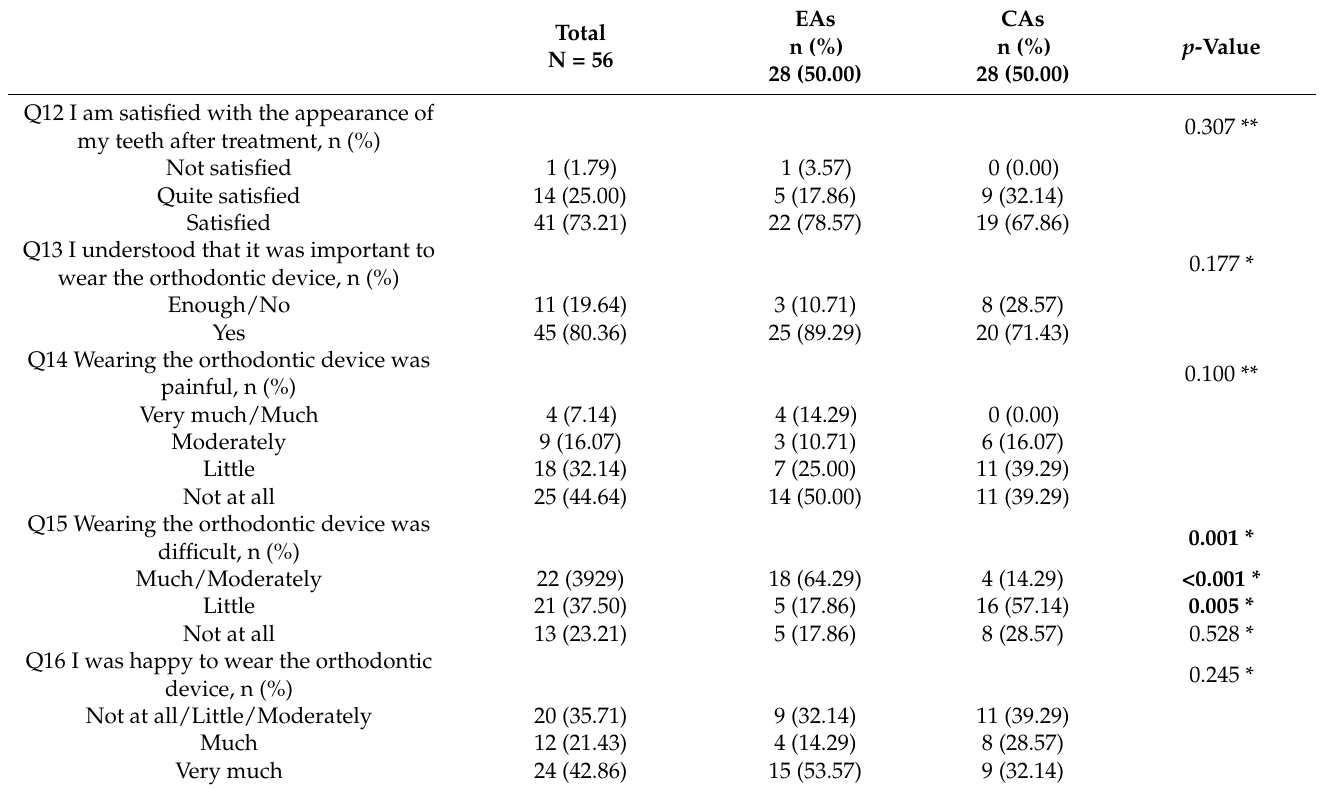
Table 3. Questionnaire’s items addressed to the patients; EAs (Elastodontic Appliances), CAs (Clear